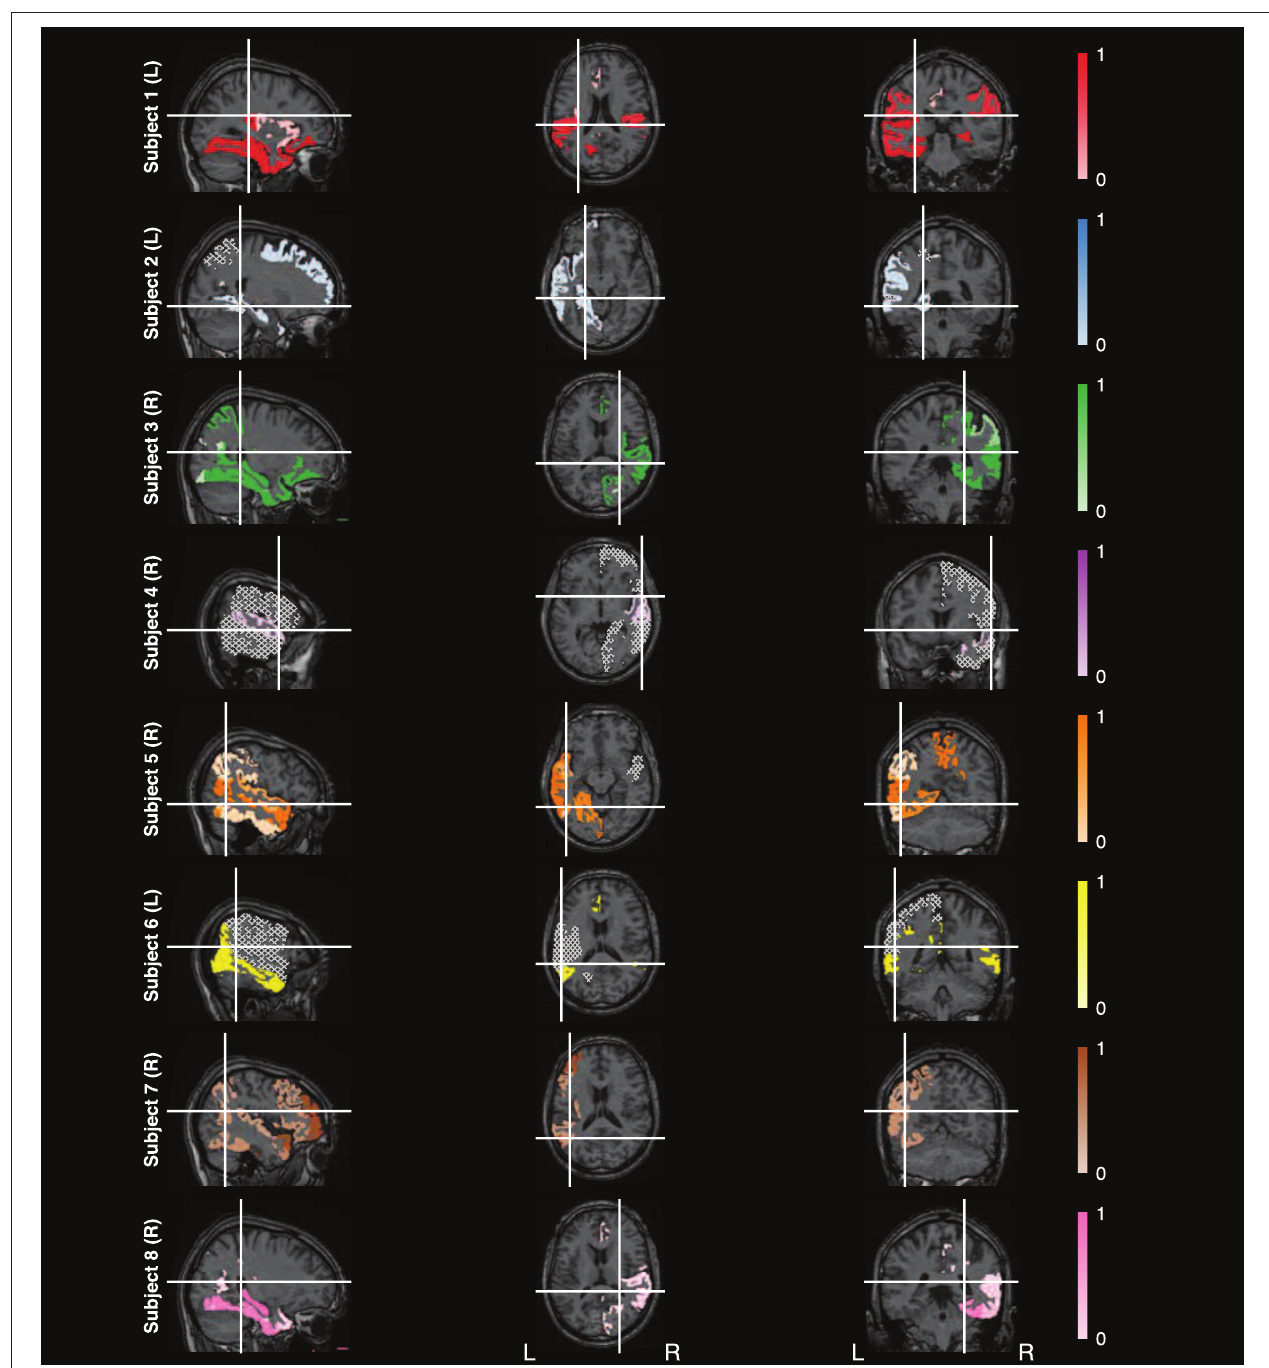
FIGURE 6 | Feature Analysis. Map of features selected for the final combined model found using the test data for eight subjects, with subject numbers labeled vertically and handedness in parentheses. The white lines in each slice represents at which slice in the other viewpoints were taken. Electrode contacts selected as features were matched to labels from the Mori atlas (Mori et al., 2005). Brain regions that matched the feature labels were then highlighted on the corresponding MRI template used by the atlas. Regions were tinted based on how frequently it was selected as a final feature over 100 iterations, where regions close to zero (i.e., rarely selected as a final feature) are tinted whiter and regions close to one (i.e., often selected as a final feature) retain the original color. Not all features could be matched to an atlas label. Regions not selected as a final feature are filled in using a hatched gray area. These maps do not represent fMRI signals nor do they represent the exact location of the